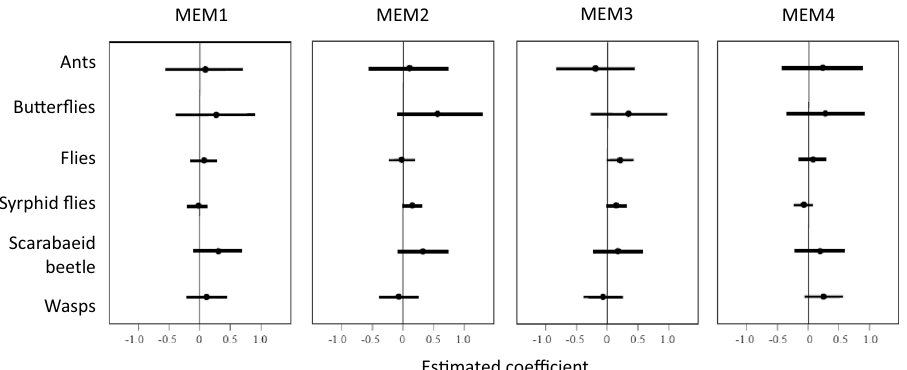
Figure 3. Results of GLM using Baysean analysis showing how spatial variables (MEM axes) infuence abundance of various insects visiting backwheat flowers. Lines indicate 95% credible intervals of the estimated coefficients of variables, and dots are the means of the coefficients. Note that positive coefficients represent positive responses of insects to MEM variables.